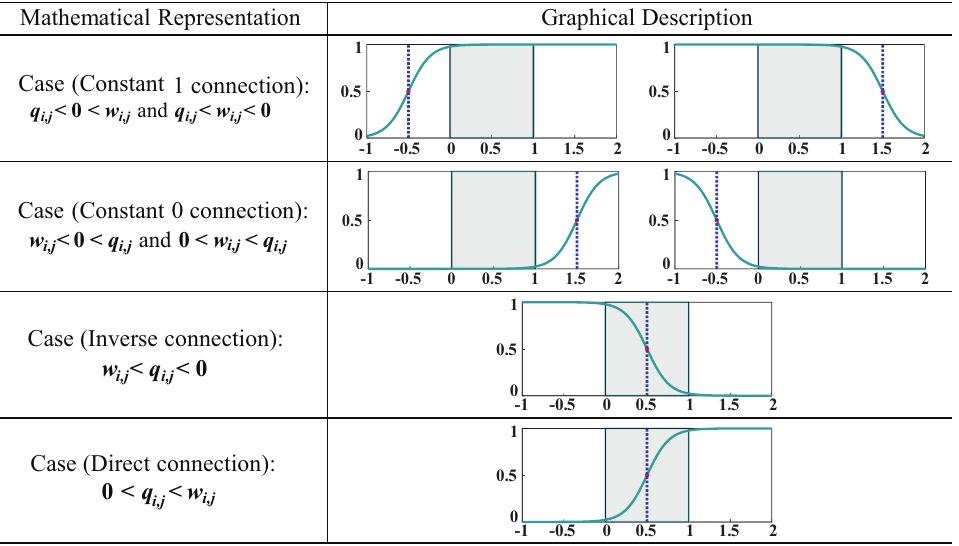
Figure 2. Four connection cases in the synaptic